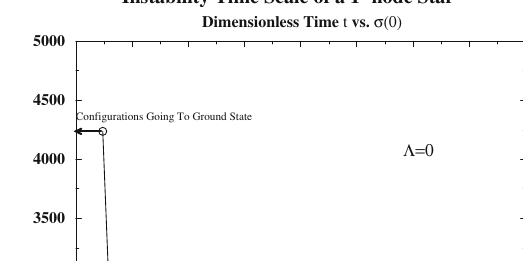
Fig. 16 The instability time scale of an excited boson star (the fi rst excitation) to one of three end states: (i) decay to the ground state, (ii) collapse to a black hole, or (iii) dispersal. Reproduced with permission from Balakrishna et al.